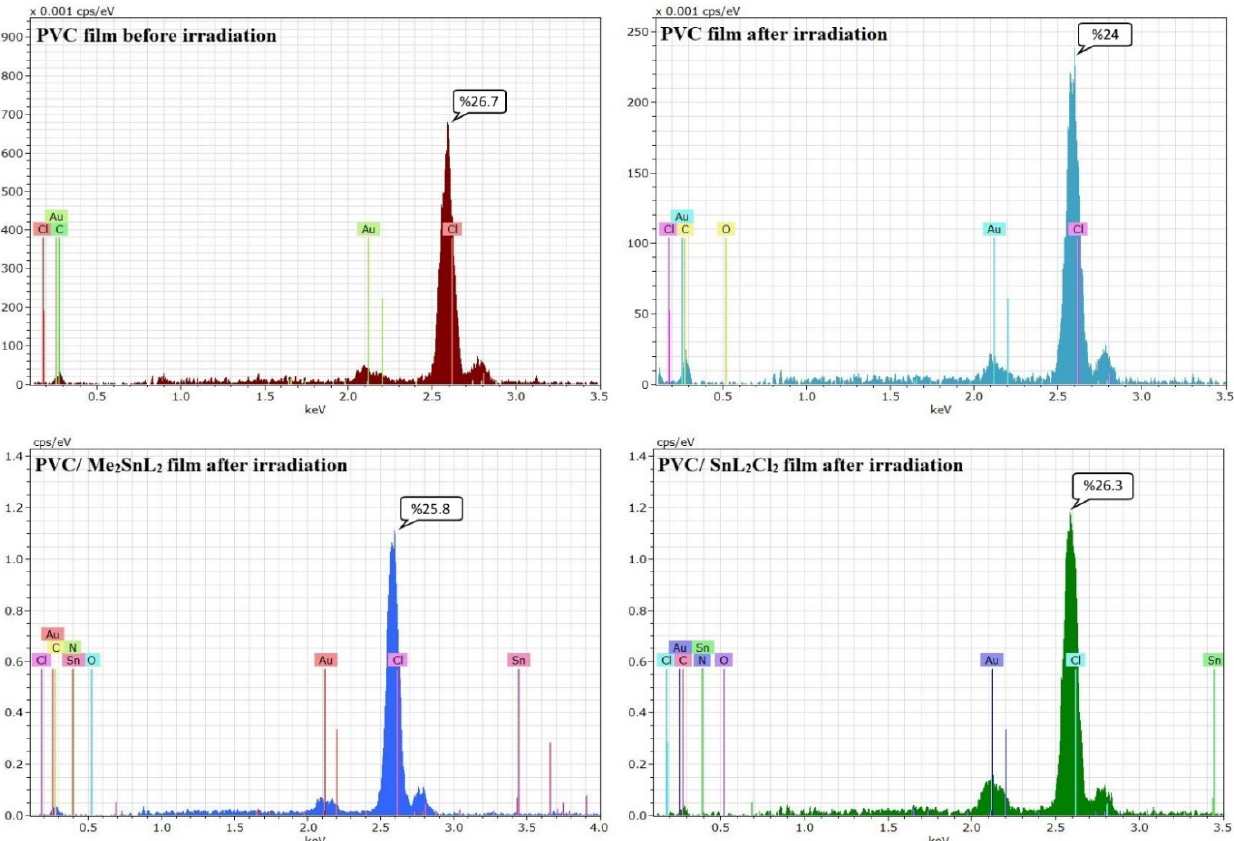
Figure 10. Energy-dispersive X-ray graph of PVC films.